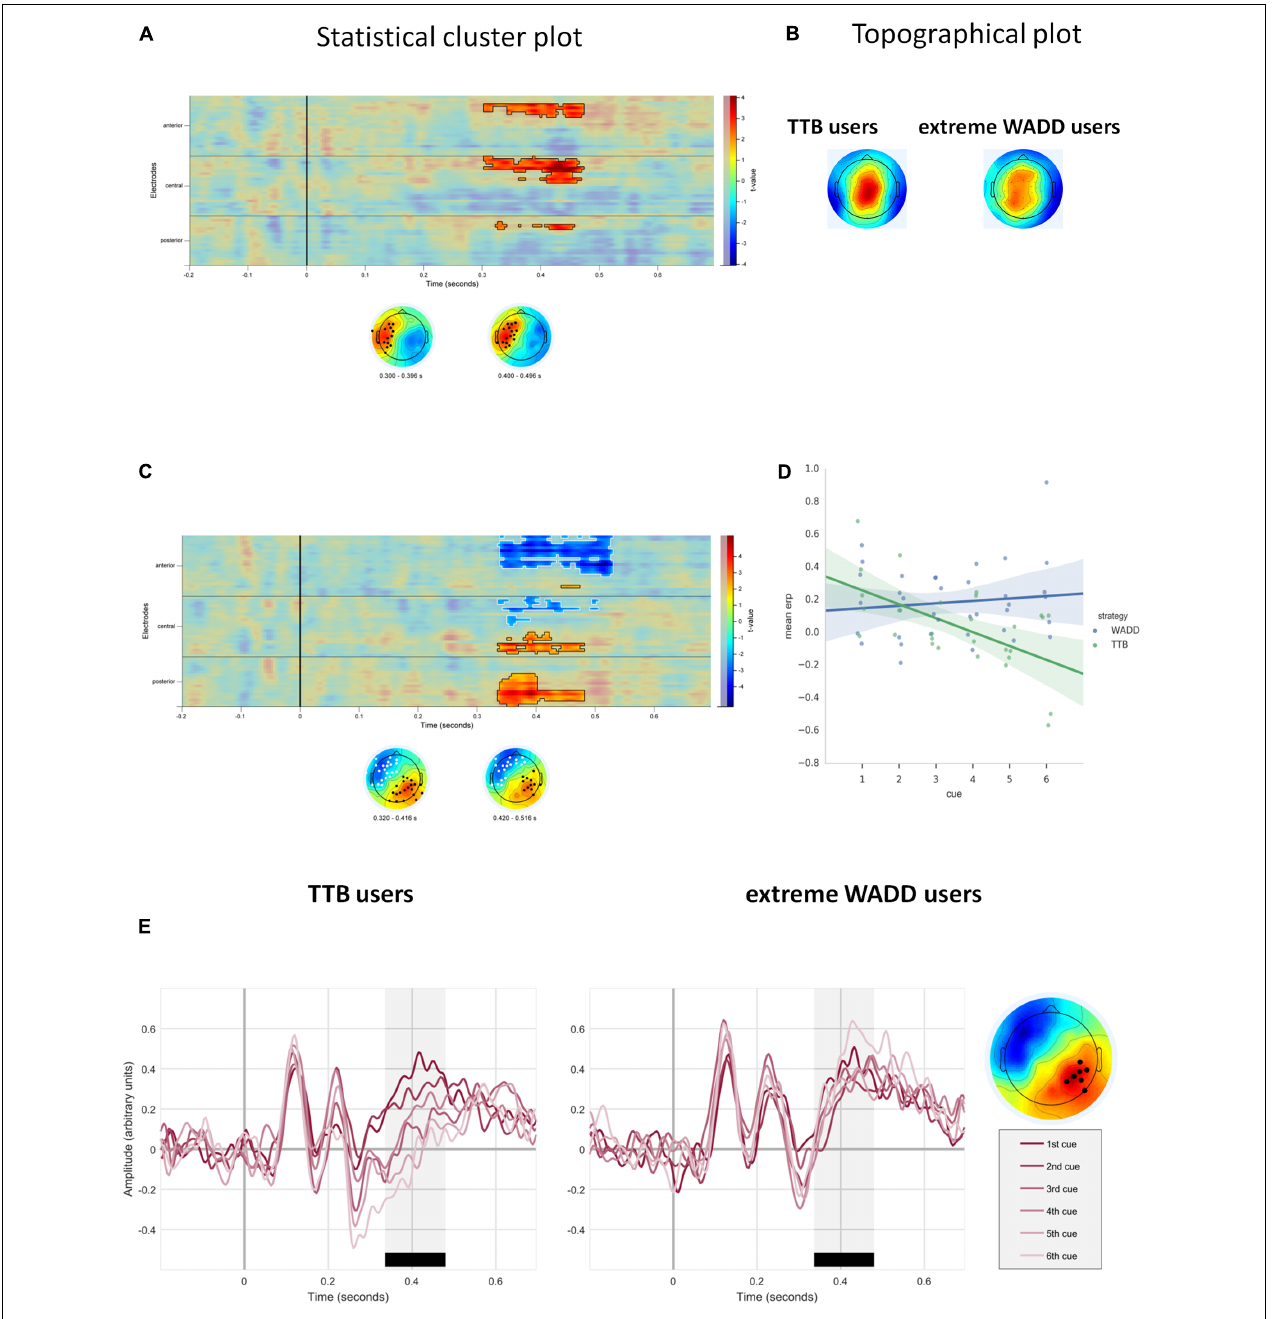
FIGURE 4 | (A) Temporal and scalp distribution of the main effect of strategy preference on EEG signal amplitude. (B) Topographical plots of the standardized voltage of the P3 component, averaged across trials and cues, for the groups of TTB users and extreme WADD users. (C) Temporal and scalp distribution of the cue number and strategy preference interaction effect. (D) Distribution of averaged EEG amplitudes to decision cues for TTB users and extreme WADD users, at the parietal electrode cluster within the time window 350–450 ms. (E) ERPs to decision cues plotted for the TTB users and extreme WADD users at the parietal